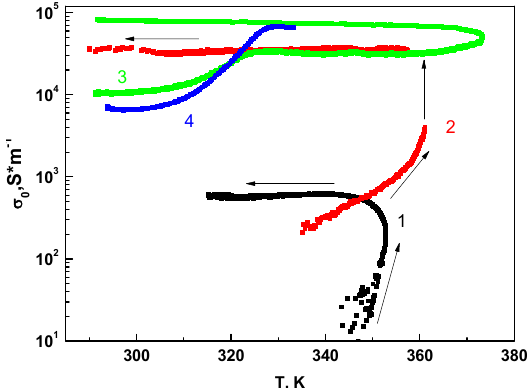
Figure 12. Temperature dependence of preexponential factor σ 0 for four heating–cooling circles of MBI-phosphite.